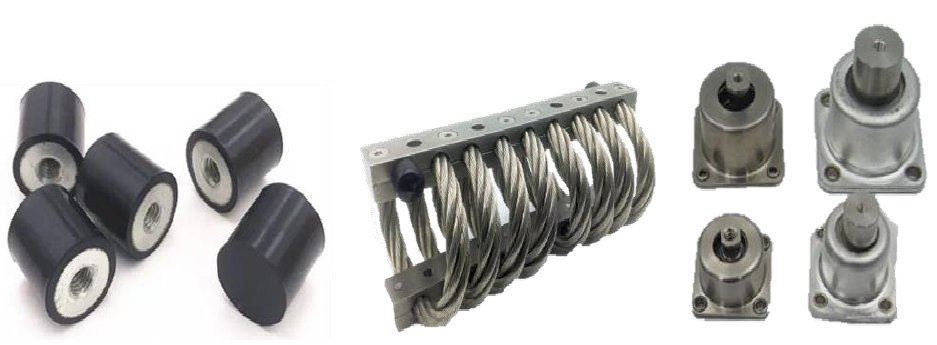
Figure 15. Typical shock isolators made of rubber, spring, etc.